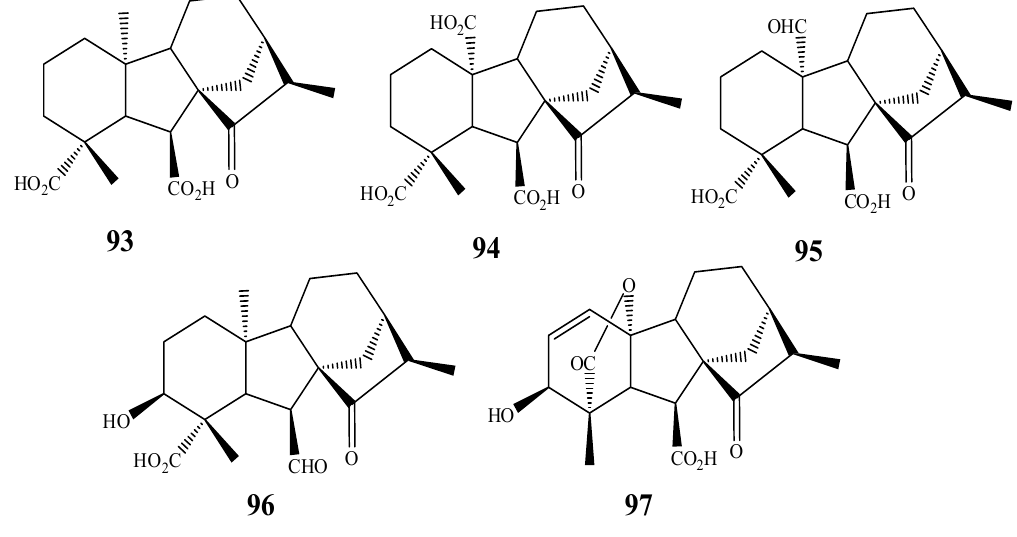
Figure 18. Rearrangement product formed in the biotransformation of 7-oxo- ent -kaur-16- ene by G.